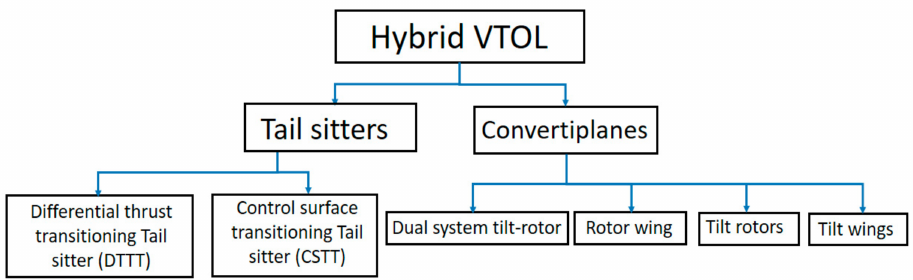
Figure 1. Classification of hybrid VTOL